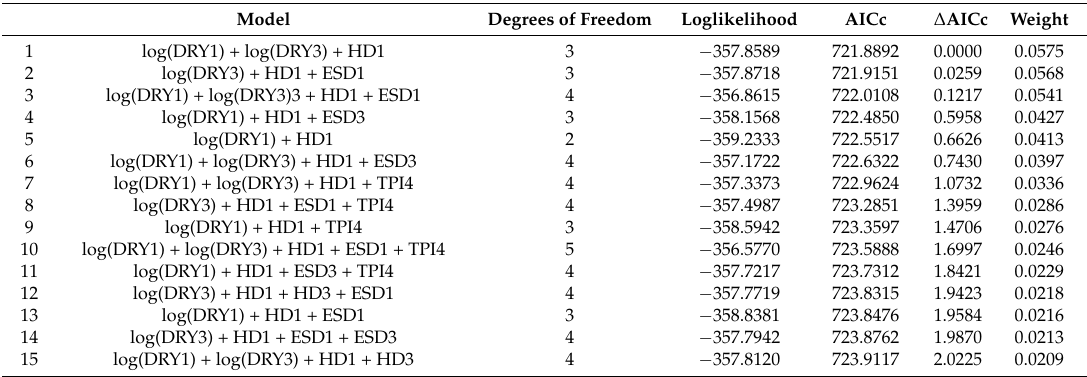
Table A1. Model comparisons based on AICc. Results for the 15 candidate models ( ∆ AICc < 2) are presented. The selected model is